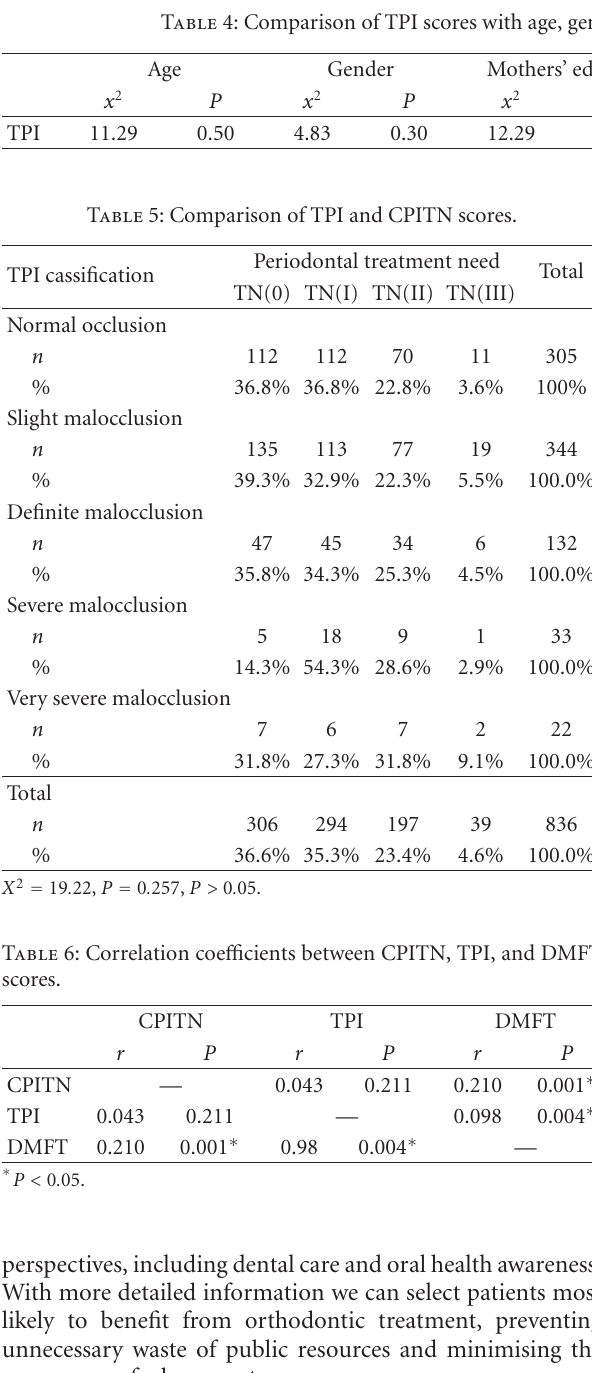
Table 4: Comparison of TPI scores with age, gender, parental education, and parental monthly income.